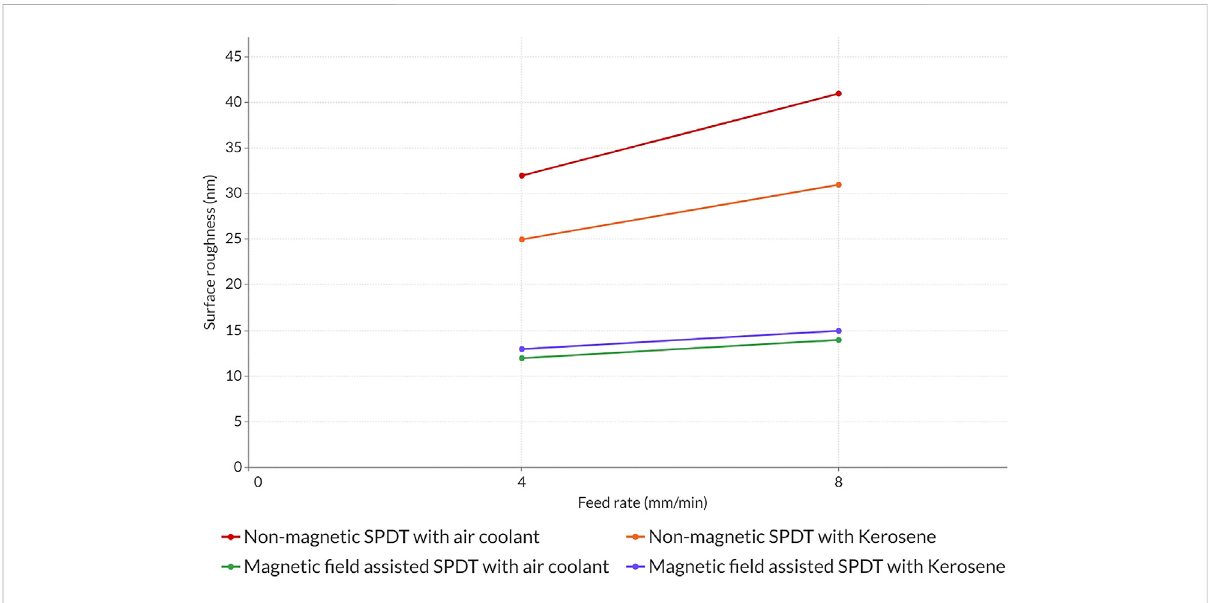
FIGURE 7 The effect of feed rate on the quality of surface fi nish with a depth-of-cut of 4 μ m at a cutting speed of 1500